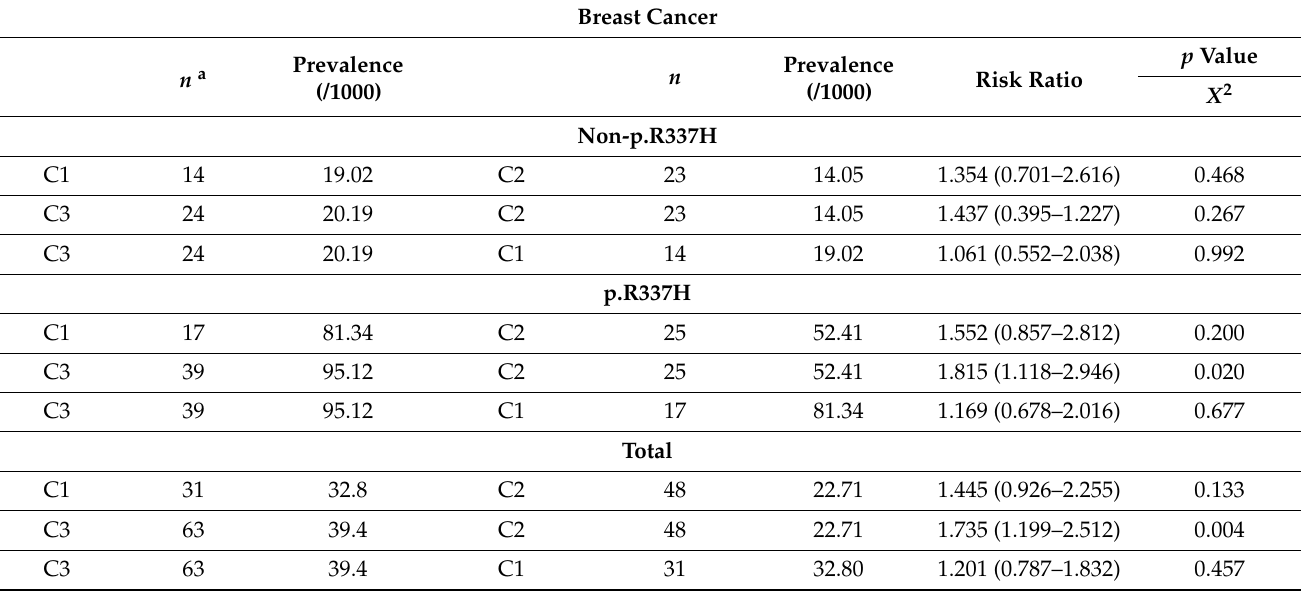
Table 2. Prevalence and risk ratio of developing BC in three subregions (C1, C2, and C3) of Paran á state among p.R337H carrier and noncarrier women.